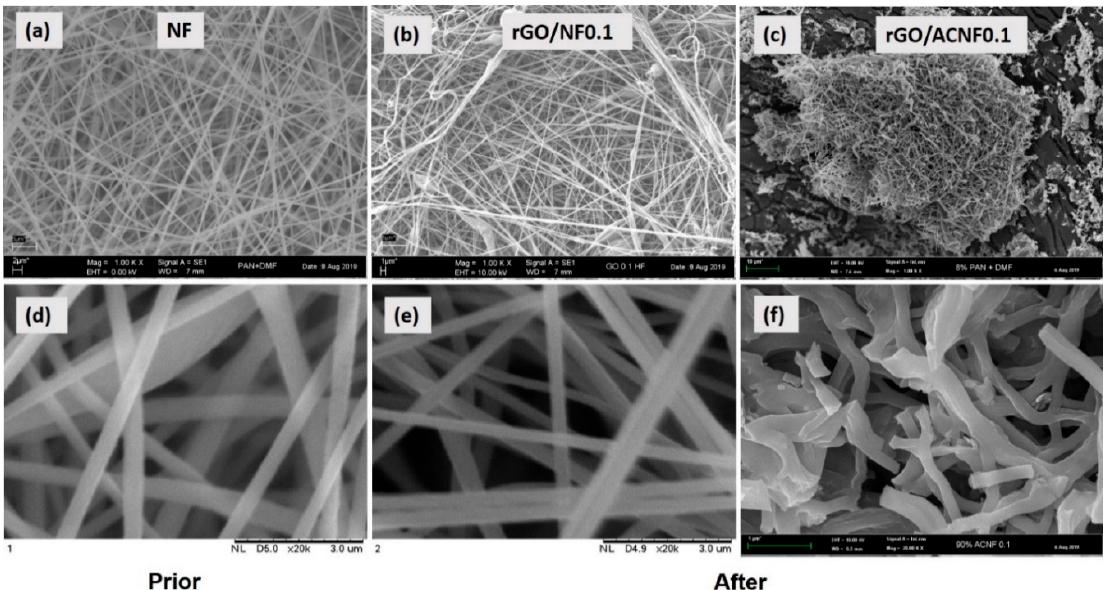
Figure 5. FESEM micrographs of NF, rGO/NF0.1 and rGO/ACNF0.1 composite at different magnifications ( a – c ) of 1000× magnification and ( d – f ) of 20,000× magnification.